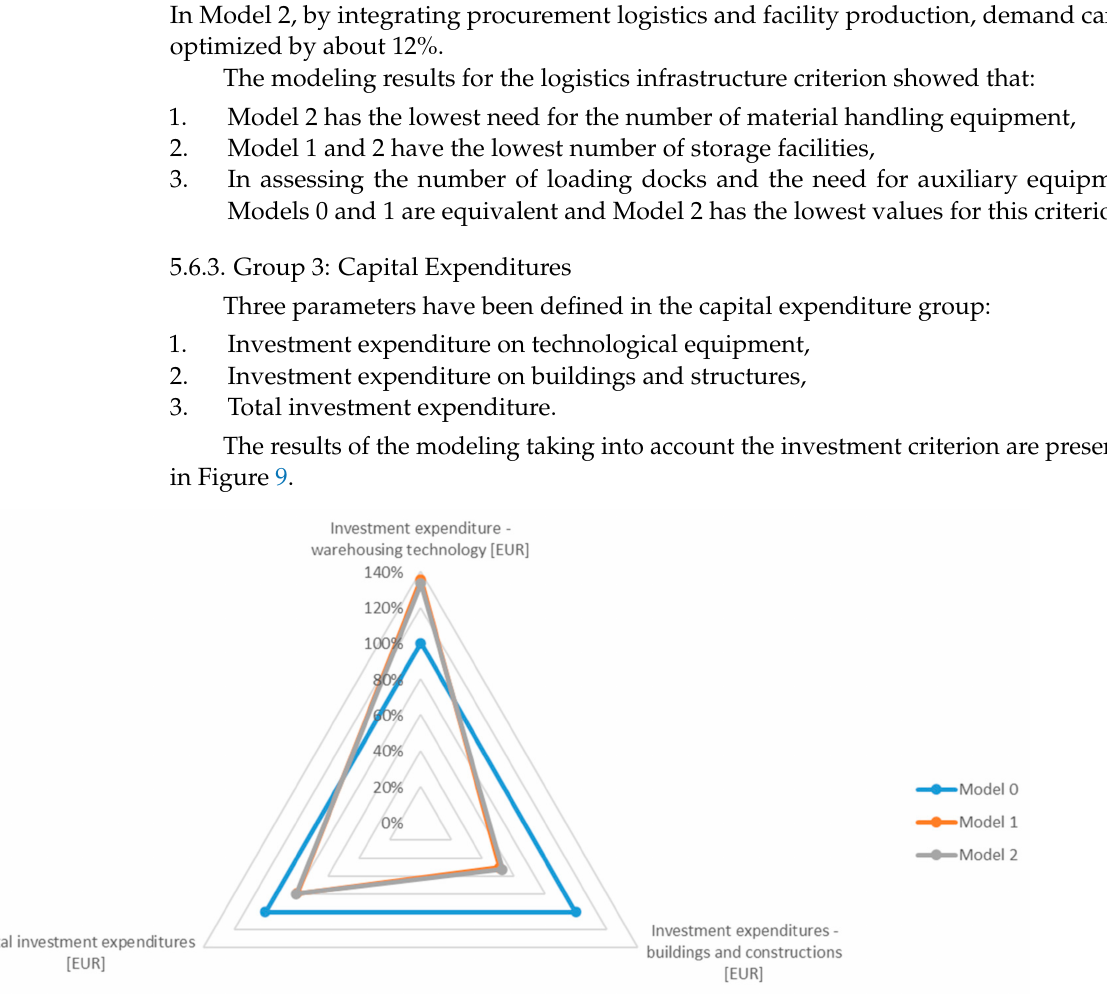
Figure 9. Results of the PL9A modeling of the Logistics System—Group 3—Investment